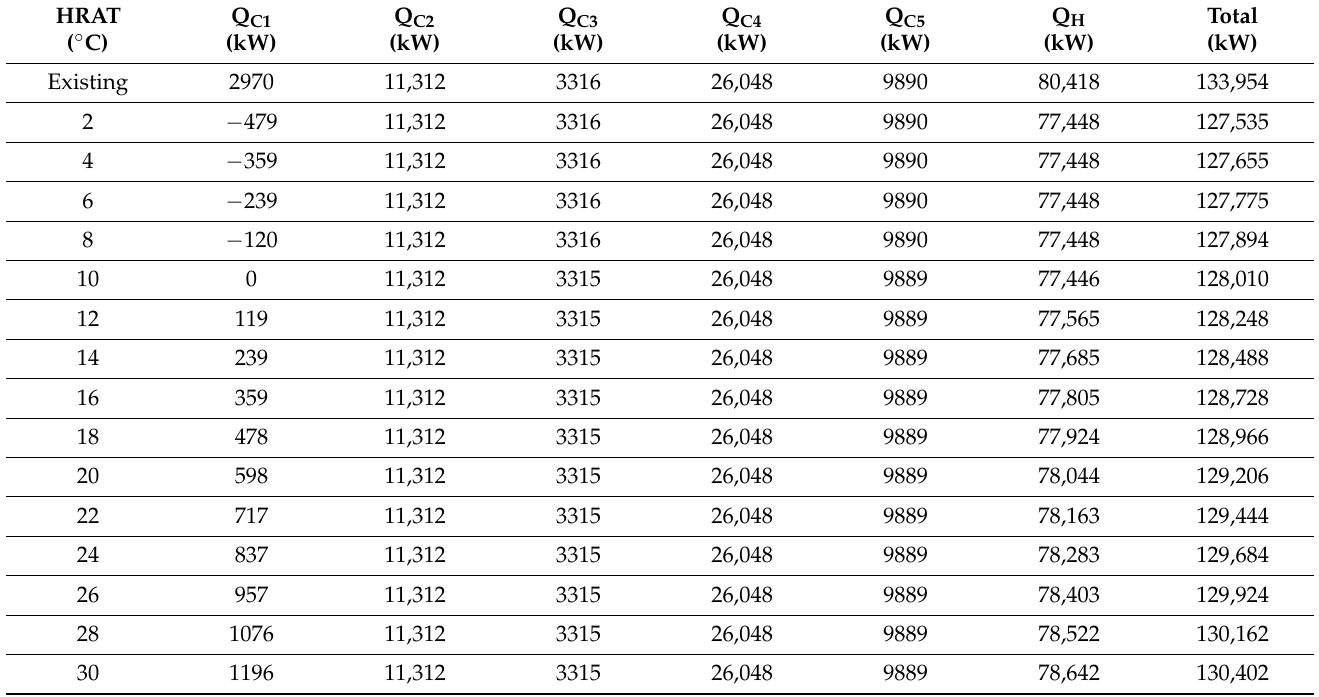
Table A7. External energy consumption at different HRAT values for option